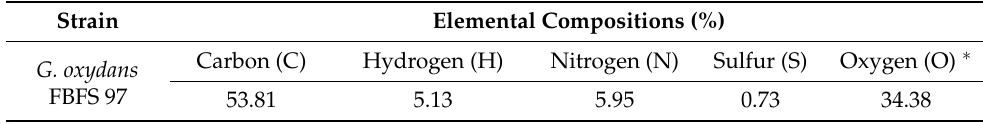
Table 2. Elemental composition analysis of the melanin produced by G. oxydans FBFS 97.